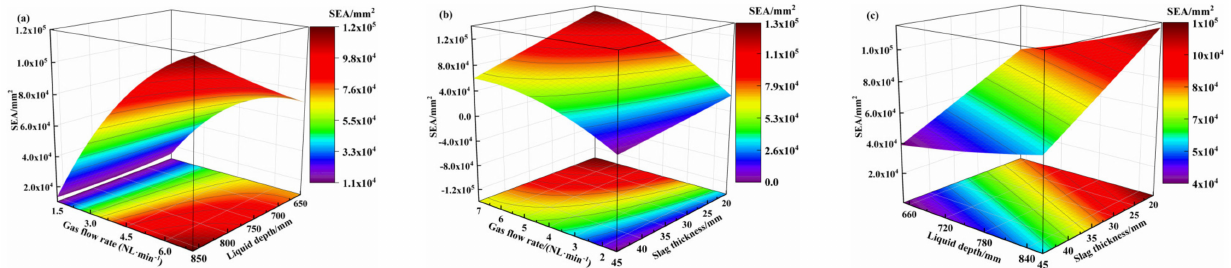
Figure 10. The 3D response surface diagram of SEA under the interaction of ( a ) gas flow rate and liquid depth, ( b ) gas flow rate and slag depth, ( c ) liquid depth and slag depth.